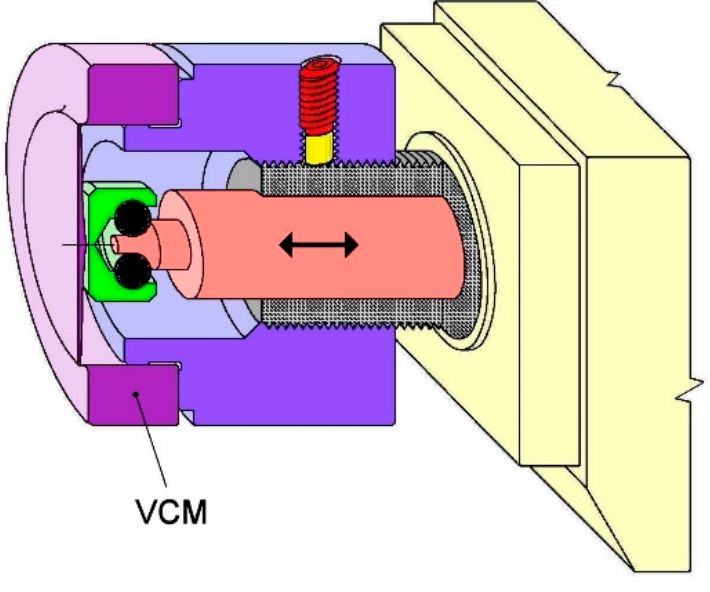
Figure 14. Tulip-like VCM assembly. Figure 14. Tulip ‐ like VCM assembly.